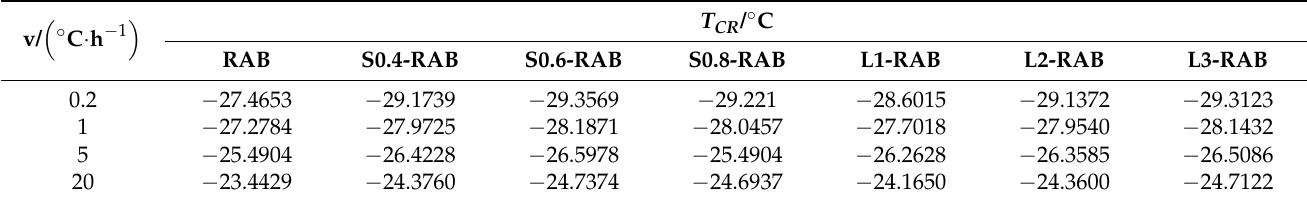
Table 3. T CR for